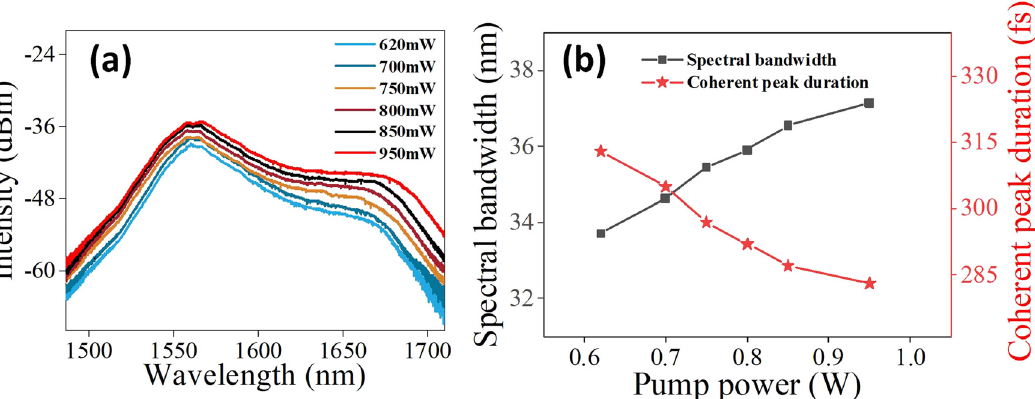
Figure 10: The characteristics of NPL at different pump powers, (a) spectra at different pump power, (b) curves of spectral bandwidth and pulse duration with different pump power.